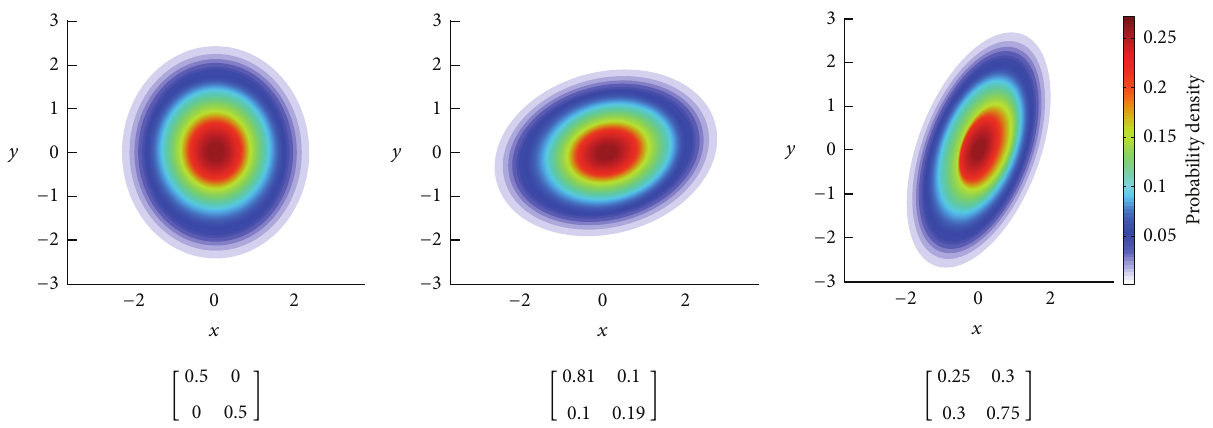
Figure 5: Three samples of possible bivariate normal distribution for point detection error of same MEr, where MEr is the Euclidean distance between the detected point and the ground truth divided by width of the detected face. The diagonal elements of the matrix contain the variances ( 𝜎 2 𝑥 , 𝜎 2 𝑦 ) for errors in 𝑥 - and 𝑦 -coordinates, while the off-diagonal elements contain the covariances between the errors of both coordinates.